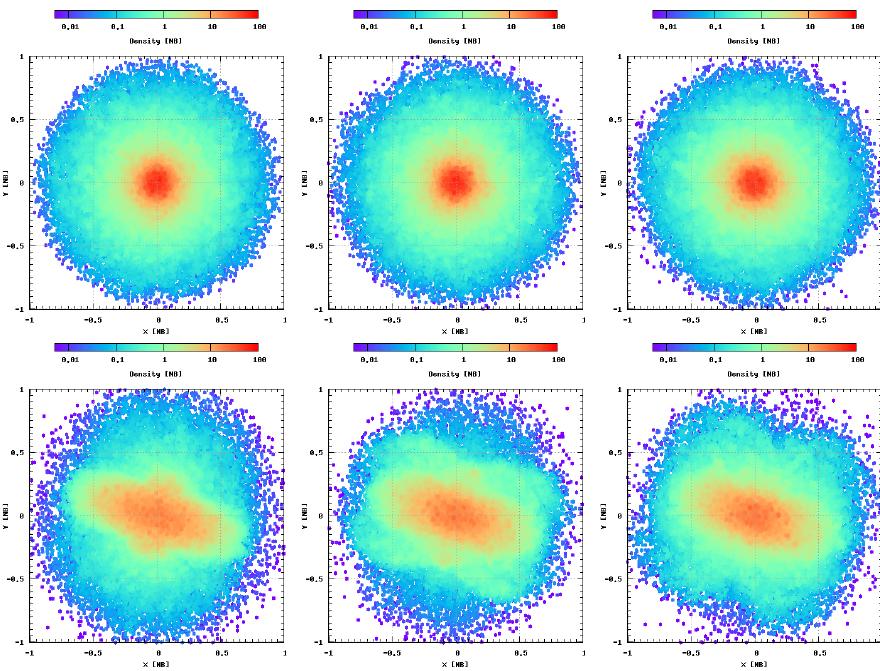
Fig. 3. Manifestation of ROI for q = 0, L T = 0 . 2973: initially spherically symmetric configuration transforms into a flattened, triaxial, and then even more complex